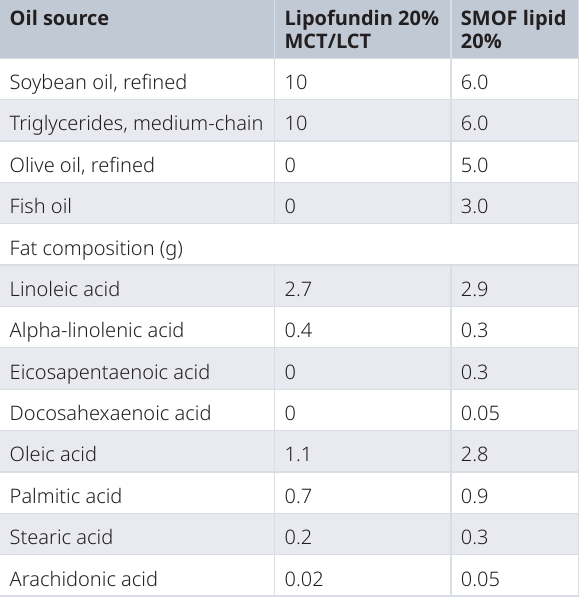
Table 1. Comparison of intravenous lipid emulsion